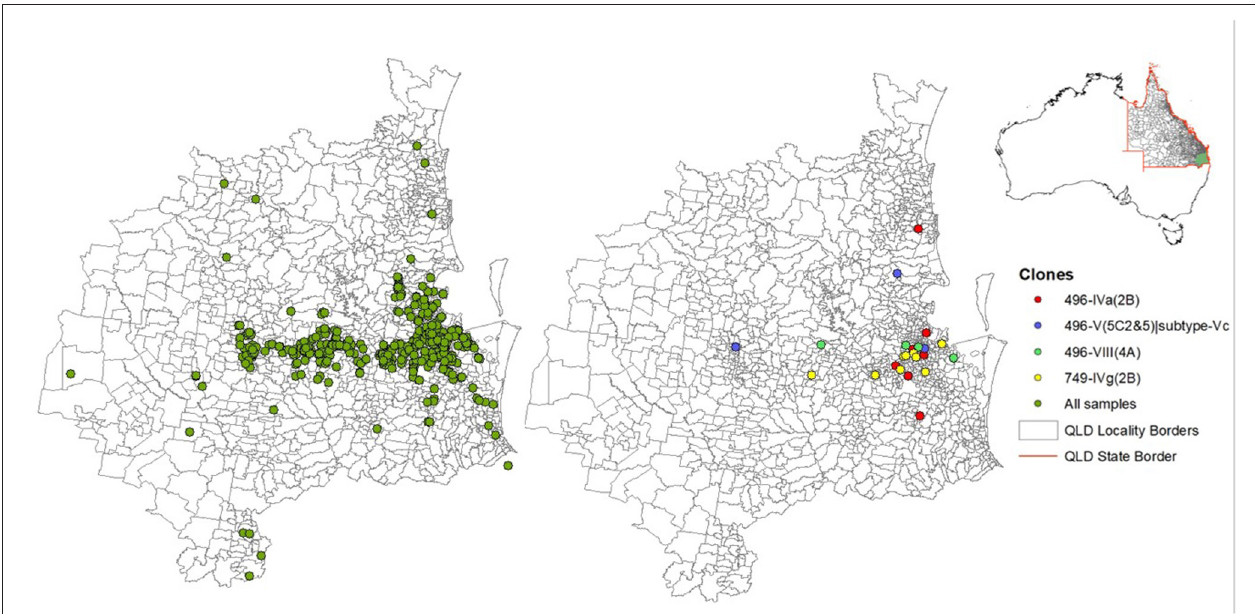
FIGURE 3 | A map showing the distribution of sampled animals and common methicillin-resistant Staphylococcus pseudintermedius clones. The two maps with sampled points correspond to the green area highlighted in the map of Australia, within the Queensland (QLD) border. ( sat4A ), β -lactams ( blaZ , mecA ), macrolides ( ermB ), CHL ( cat- pC221 ), TET ( tetM ), and trimethoprim ( dfrG ). The